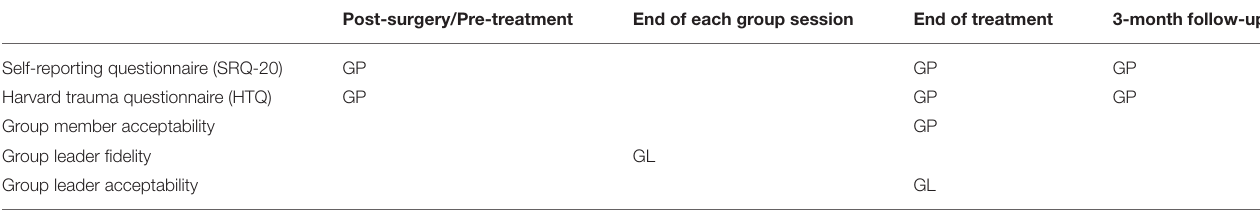
TABLE 3 | Assessments and instruments.